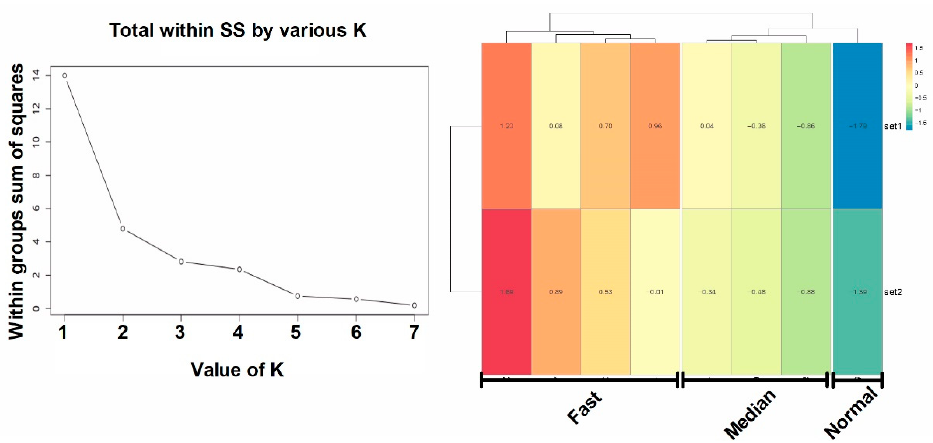
Figure 3. Clustering results of manually collected data on tree height and diameter at breast height (DBH) of Chinese fir in Jiangle, China. (Left) represents K-mean clustering results plotted by the number of clusters and the validity; (Right) shows the heatmap plot against first 2 principal components (set1 & set2 represent tree height and DBH, respectively) of each cluster (Fast, Median, and Normal)